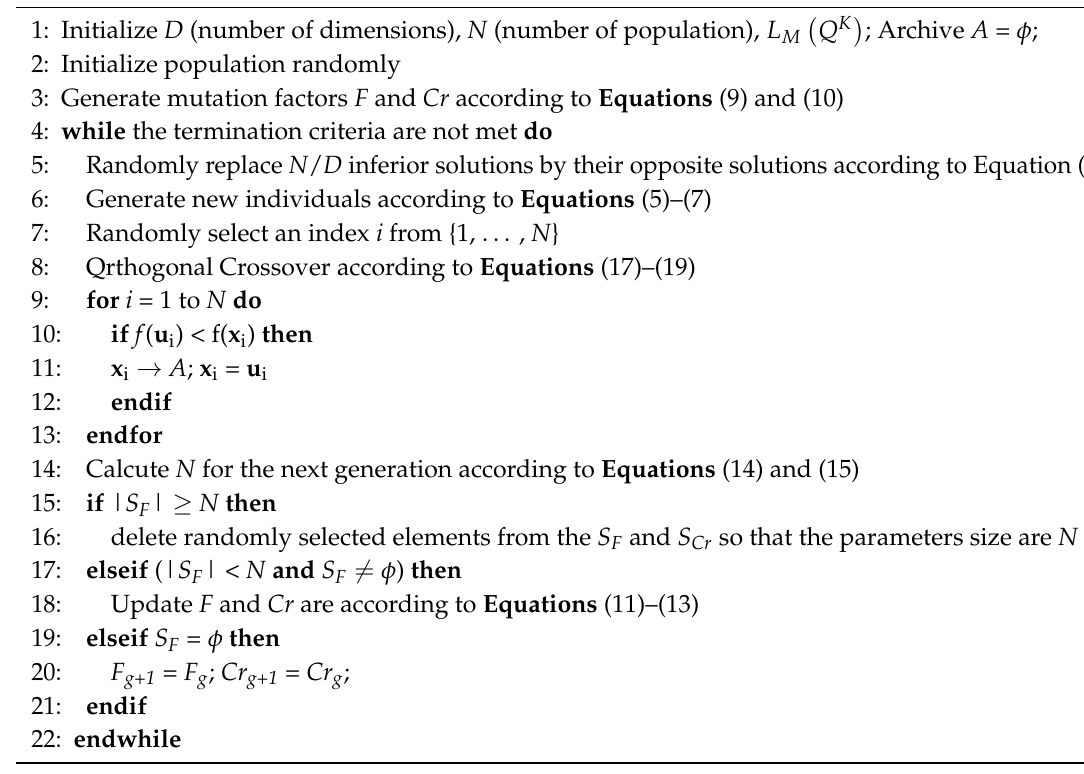
Algorithm 1. MCPDE